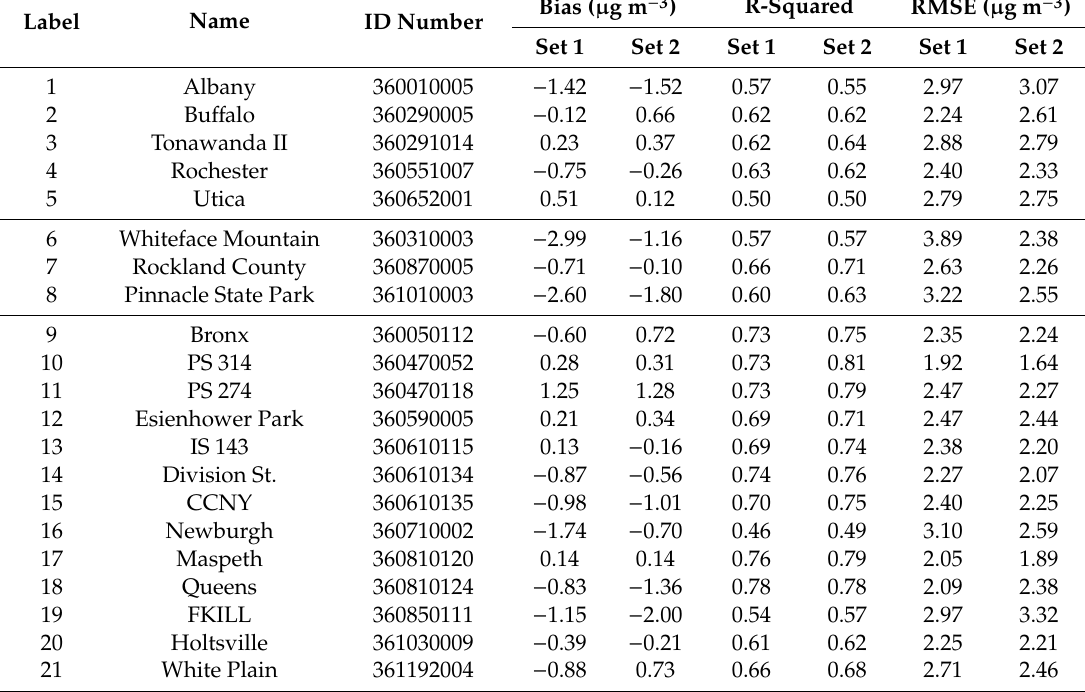
Table A3. LOOCV testing results of the ANN models at selected air quality